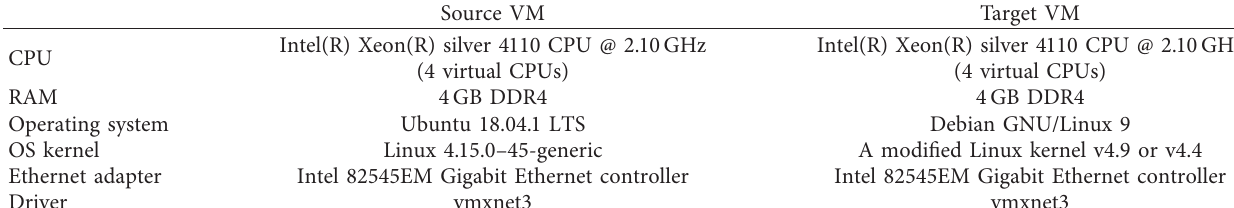
Table 2: Features of testbed hardware and software.